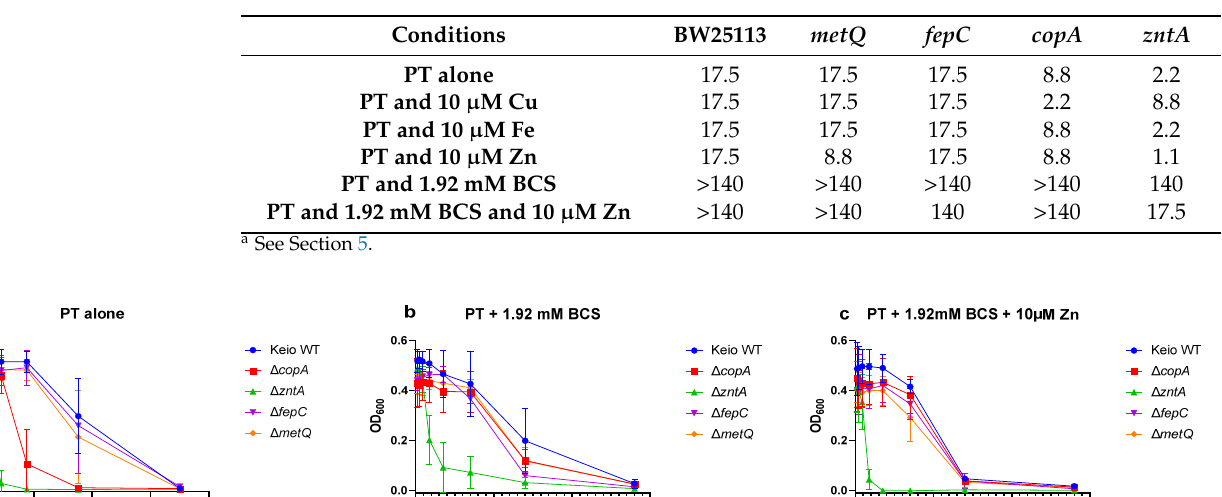
Table 3. Minimum inhibitory concentrations (MICs) of pyrithione (PT) against E. coli BW25113 and knockout strains in the presence of metals a .